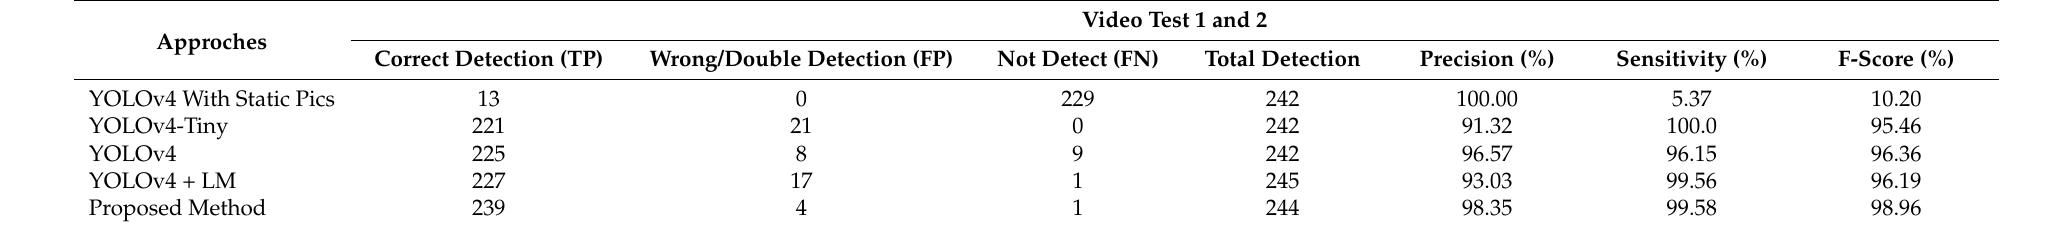
Table 6. Experimental results (other performance